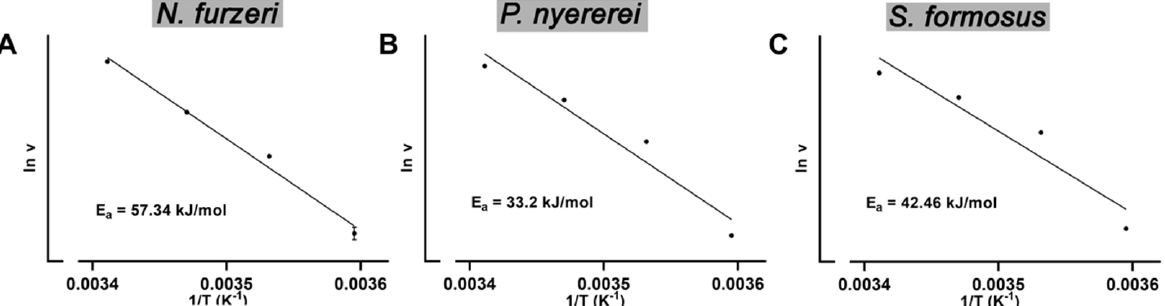
Figure 5. Activation energies for AA oxygenation catalyzed by the selected bony fish ALOX isoforms. The temperature profiles for AA oxygenation by the randomly selected bony fish ALOX isoforms were determined as indicated in Figure 4. The catalytic activities assayed in the temperature range between 5 ◦ C and 20 ◦ C were used to construct the Arrhenius diagrams and from the slope of the resulting lines the activation energies were evaluated for the different bony fish ALOX isoforms. At each temperature two independent activity assays were carried out and thus, the calculated activation energies for each enzyme are based on eight independent experimental data points. ( A ) N. furzeri , ( B ) P nyererei , ( C ) S. formosus